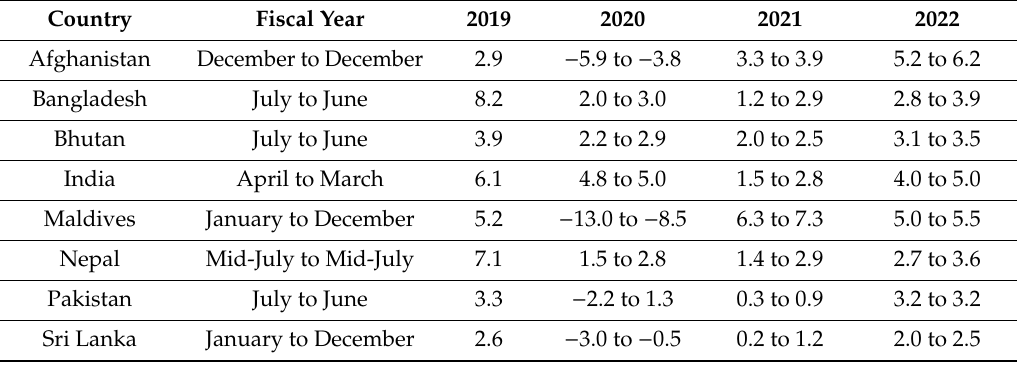
Table 14. Real gross domestic product (GDP) at market price in